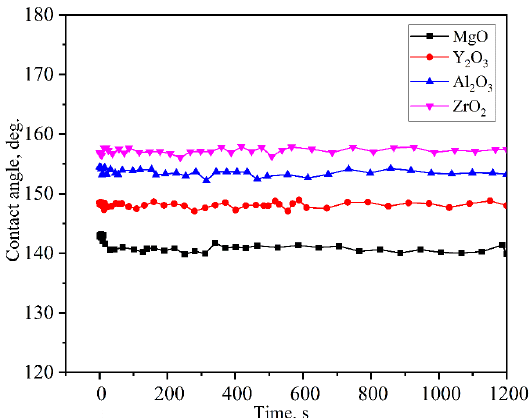
Figure 5. Variation in the apparent contact angle with time with regard to the Ni-20Co-20Cr-10Al-1.5Y alloys on the various oxide ceramic substrates at 1873 K.